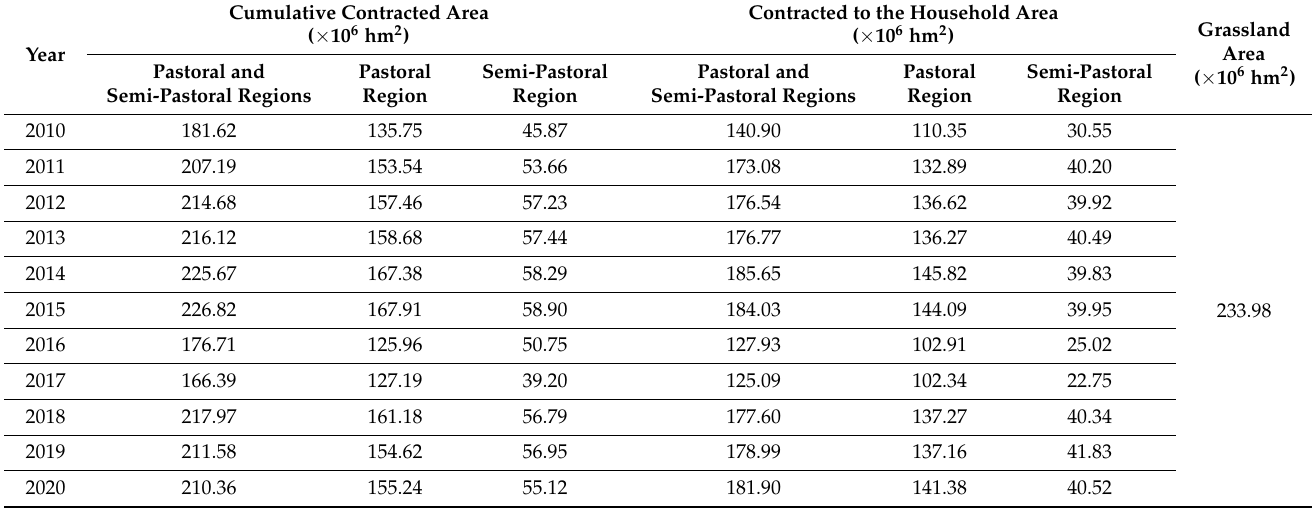
Table 1. Grassland contracting in pastoral and semi-pastoral regions in China.